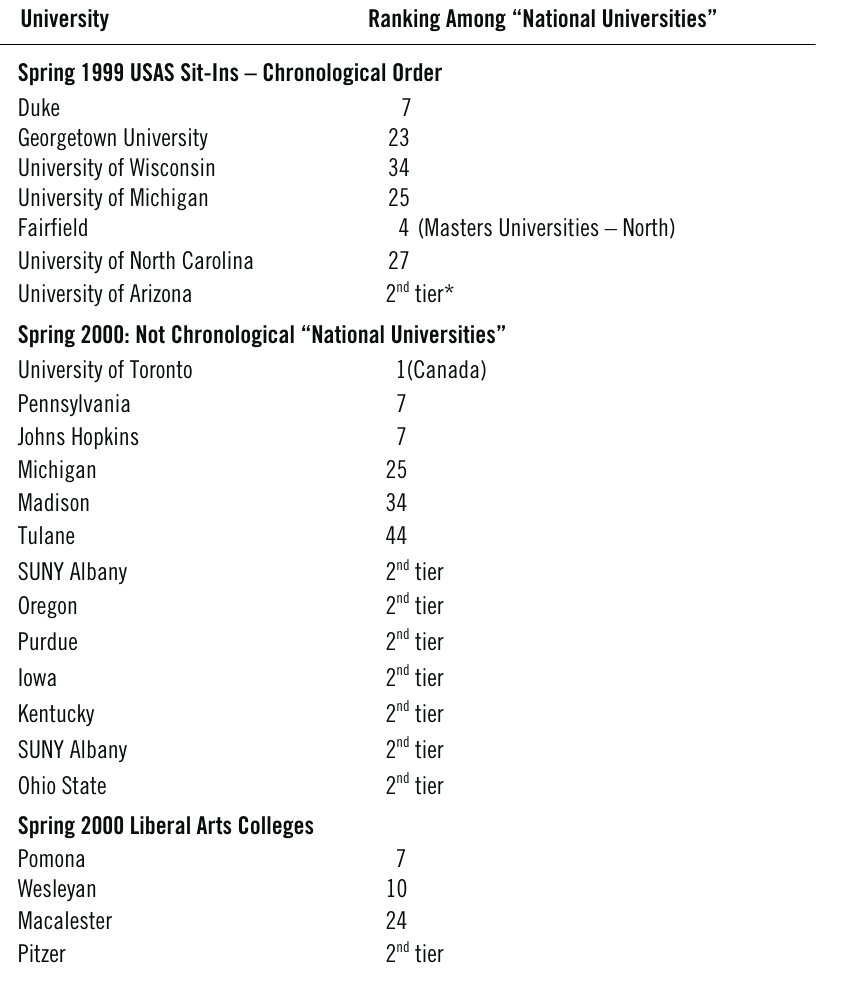
Table 3: Institutional Status and Anti-Sweatshop Sit-Ins